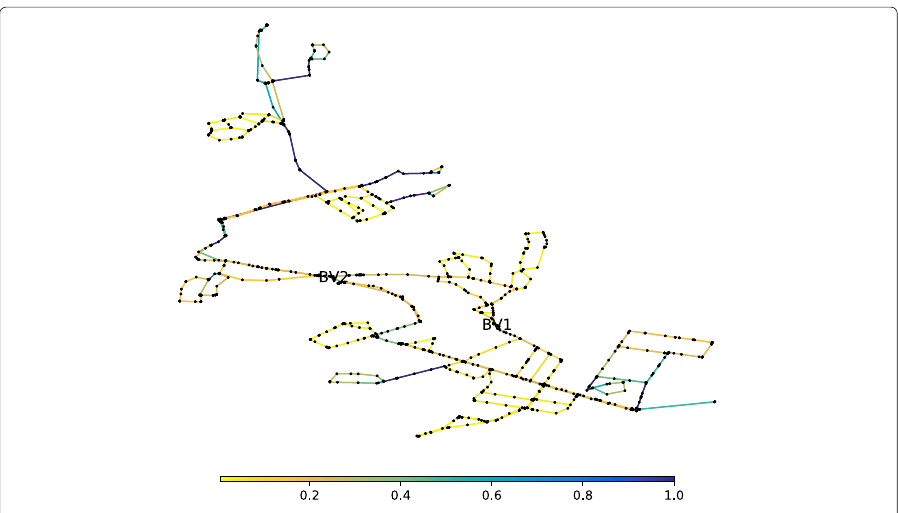
Fig. 12 WFEBC of BWFL core model links, dynamically adaptive topology. Boundary valves BV 1 and BV 2 are opened to assess the resilience of the paired